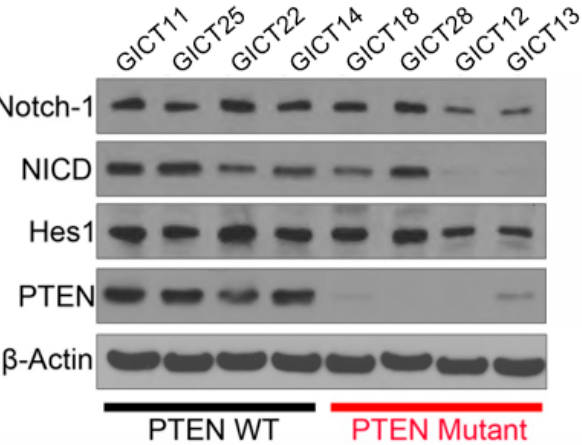
Figure 2. Western blotting of the NOTCH signaling pathway in eight GICs. Activated Notch ‐ 1 (NICD) and Hes1 were expressed in sensitive GICs. β‐ Actin was used as the loading control.